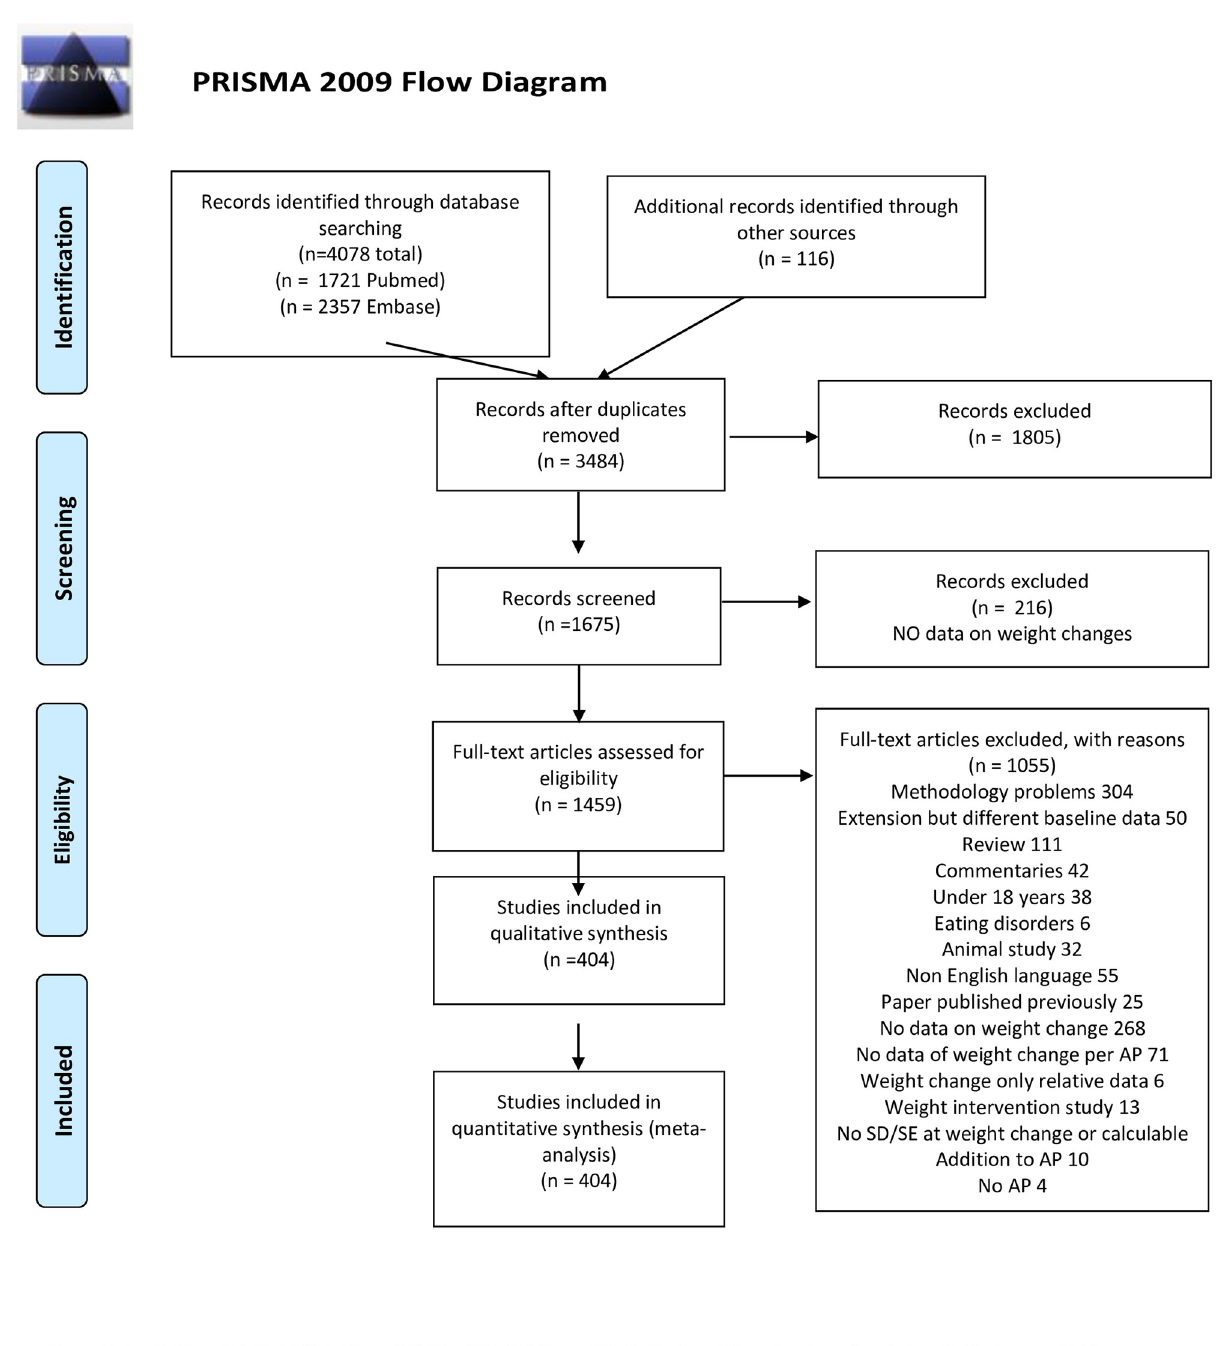
Fig 1. PRISMA flow